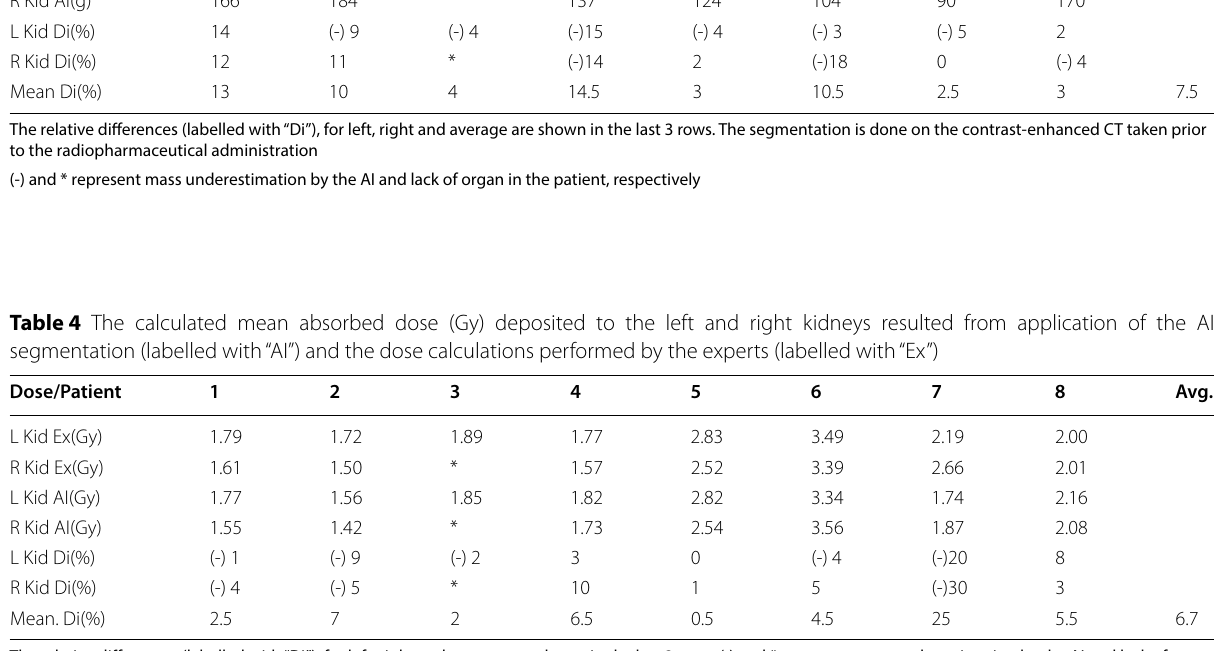
The relative differences (labelled with “Di”), for left, right and average are shown in the last 3 rows. (-) and * represent mass underestimation by the AI and lack of organ in the patient, respectively